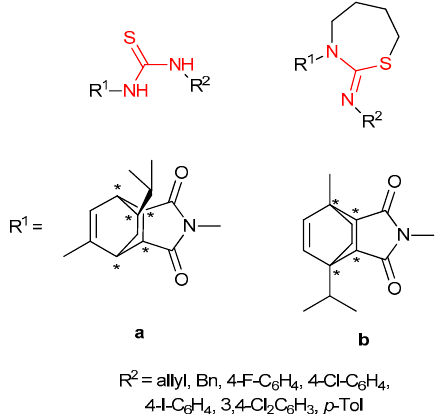
Figure 37. 1,3-Thiazepine isothiourea derivatives [364].